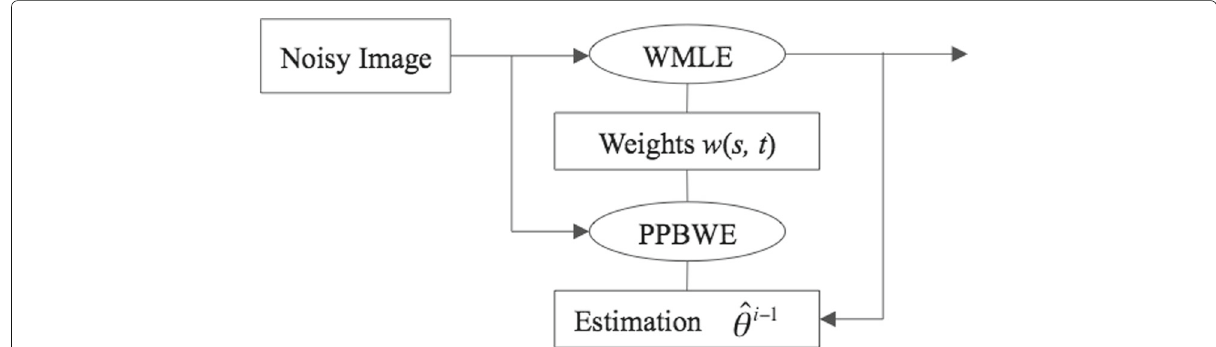
Fig. 3 Weights in PPB algorithm: computing iteratively the weights between two pixels s and t in the probabilistic patch-based (PPB) filter. The PPB weights estimator (PPBWE) uses the noisy image and the estimation values from the previous iteration in order to estimate the